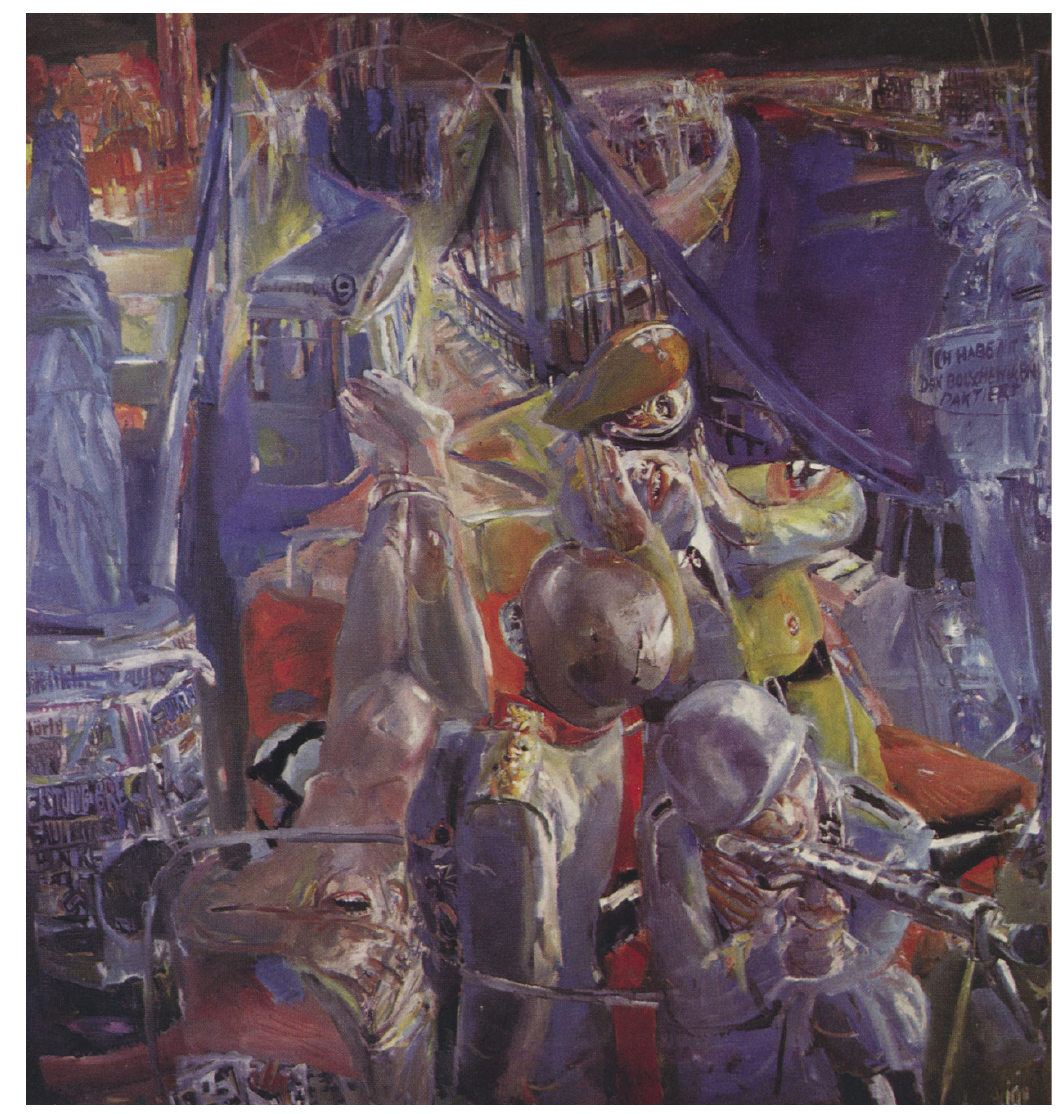
Bernhard Heisig, Fortress Breslau – The City and its Murderers , 1969. Oil on Canvas. 165 x 150 cm. (The painting no longer exists in this form; Heisig reworked it in